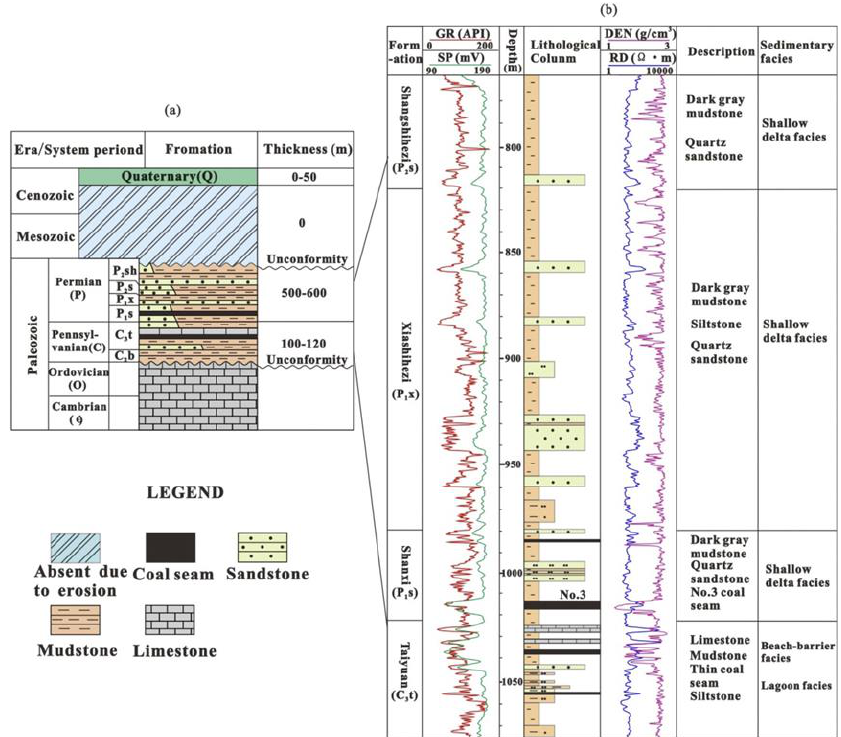
Figure 2. Stratigraphic column (a) and sedimentary characteristics of the coal-bearing strata in Zhengzhuang field (b). The data source is from well Z30 (see Figure 1 for the location). AC = acoustic logging curves; C 2 b = Benxi Formation; C 3 t = Taiyuan Formation; DEN = density logging curve; GR = natural gamma-ray logging curve; RD = deep investigate double lateral resistivity logging curve; P 1 s = Shanxi Formation; P 1 x = Xiashihezi Formation; P 1 x = Xiashihezi Formation; P 2 sh = Shiqianfeng Formation.